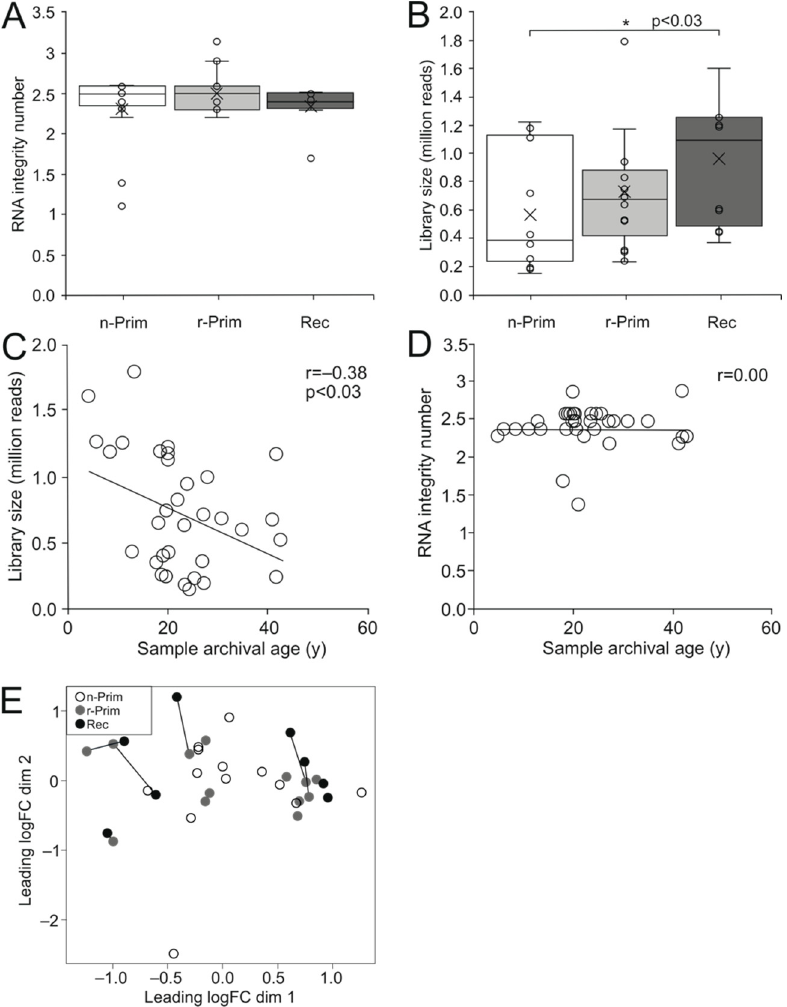
Figure 2. The cDNA library size shows a weak negative correlation with the sample archival age. The RIN values did not differ significantly between the 3 AGCT sample groups ( A ). The cDNA library size was significantly higher in the Rec samples compared to n-Prim tumor samples, p < 0.03 ( B ). The cDNA library size had a weak negative correlation with the sample archival age in years (y), r = − 0.38, p < 0.03 ( C ), but there was no correlation between the RIN value and the sample archival age in years (y) ( D ). We performed a principal component analysis on the sequenced samples to visualize the relationships between the samples. White circle represents the n-Prim, grey circle represents the r-Prim, and black circles represent the Rec samples, respectively ( E ).